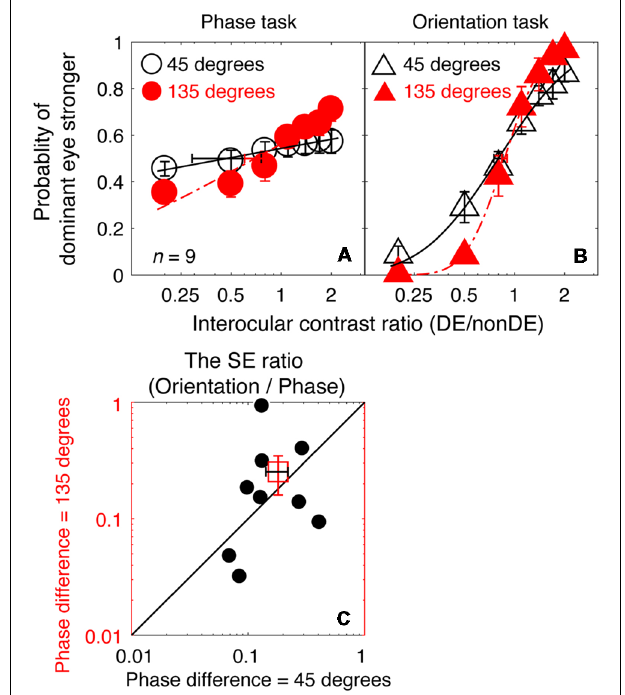
FIGURE 5 | A comparison of the precision of the two tasks at 8 cycles/degree; interocular phase difference of 45 ◦ vs. 135 ◦ . The average psychometric functions for the two tasks and two interocular phase differences are plotted in (A,B) : black circles and black triangles represent the mean probability of dominant eye stronger for the binocular phase combination paradigm and the binocular orientation combination paradigm when the interocular phase difference was 45 ◦ (data from Experiment 1); red circles and red triangles represent the mean probability of dominant eye stronger for the binocular phase combination paradigm and the binocular orientation combination paradigm when the interocular phase difference was 135 ◦ (data from Experiment 2). The solid and dash line represents the best fitting cumulative distribution functions. Error bars represent SEs across the nine subjects. (C) The bootstrapped SE ratio between the orientation task and the phase task at the 135 ◦ conditions was plotted as a function of that at the 45 ◦ condition for the nine observers. Each open circle represents results of one observer; the filled circle represents the averaged results. The dash line is the equal line. Error bars represent SEs across the nine